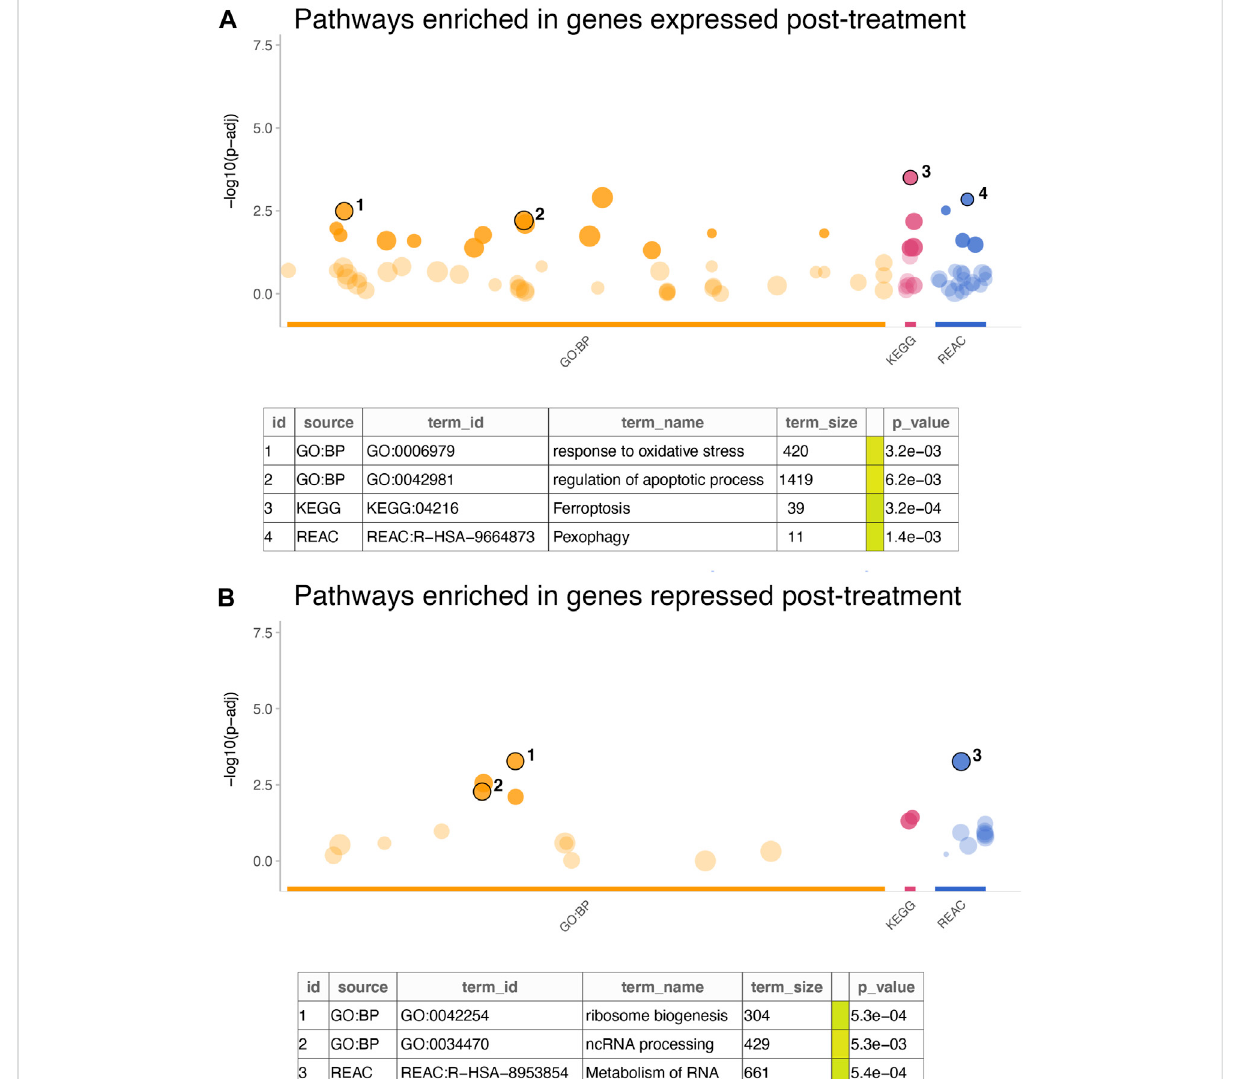
FIGURE 3 Enrichment analysis of in vitro gene signature. (A,B) The dotplots show signi fi cance of the enrichment terms from GO:BP, KEGG and REACTOME signatures, with Y-axis showing − log10 of the FDR-adjusted p -value from the enrichment test. Key signi fi cant terms enriched in genes thatwere (A) expressed athigher levelsinthetreatedcellsor (B) expressedathigher cellsintheuntreated cellsareannotatedinthetablebelow. The term size indicated number of genes in the original signature, while the color code indicates strength of evidence associated with the term. Terms supported by experimental evidence are shown in